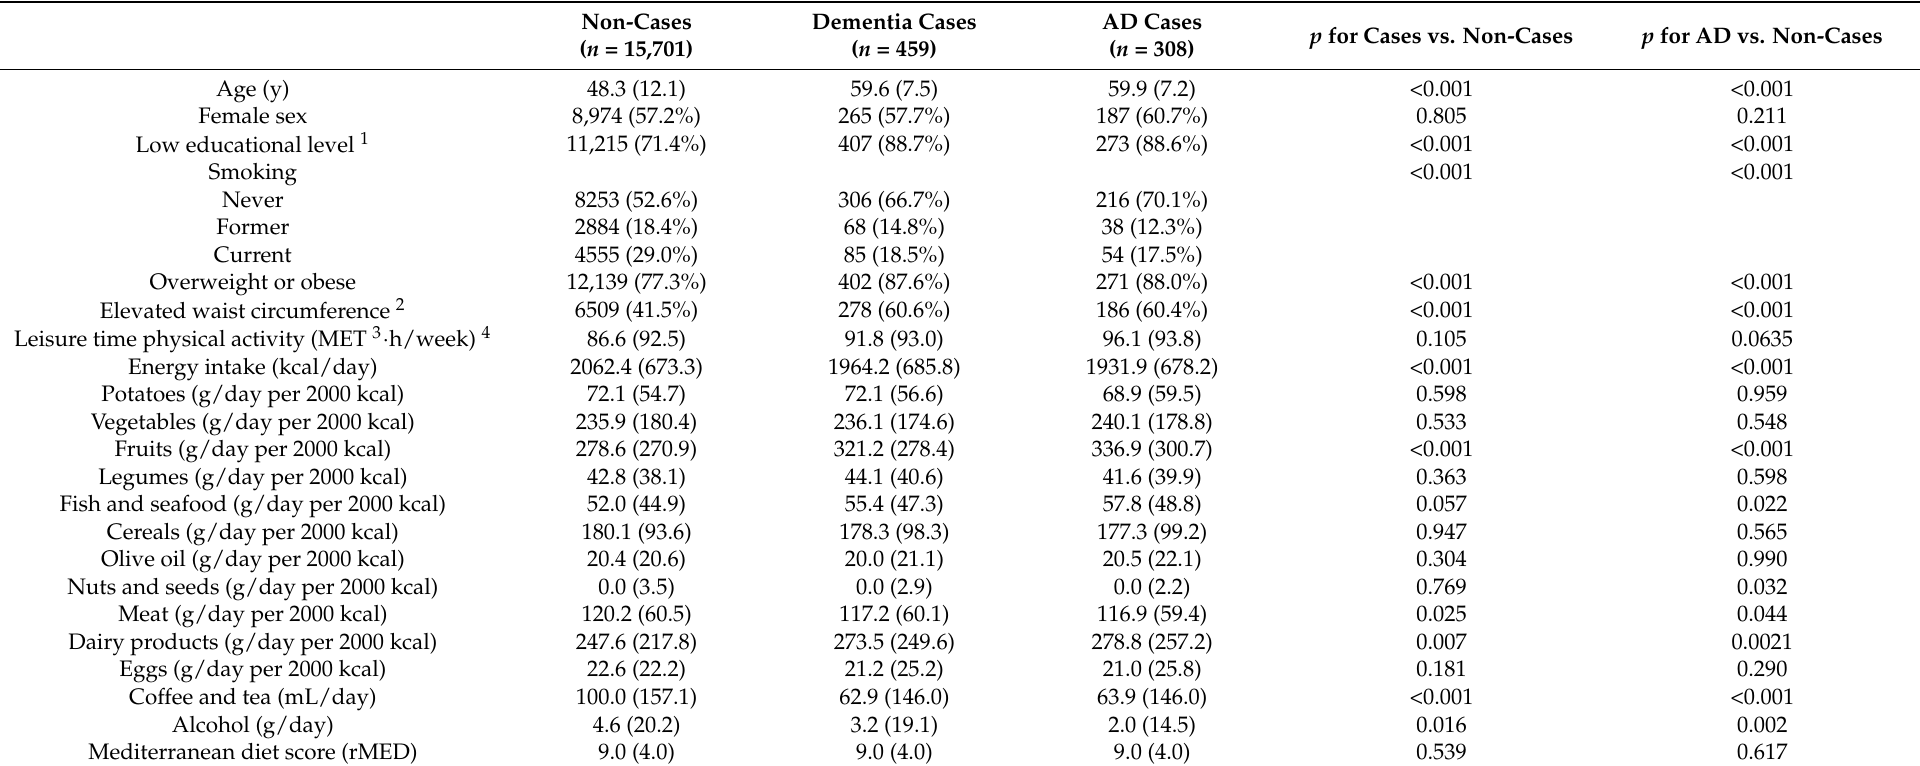
Table 1. Baseline characteristics of cases (overall dementia and Alzheimer’s disease, AD) and non-cases participating in the European Prospective Investigation into Cancer and Nutrition (EPIC)-Spain Dementia Cohort study ( N =